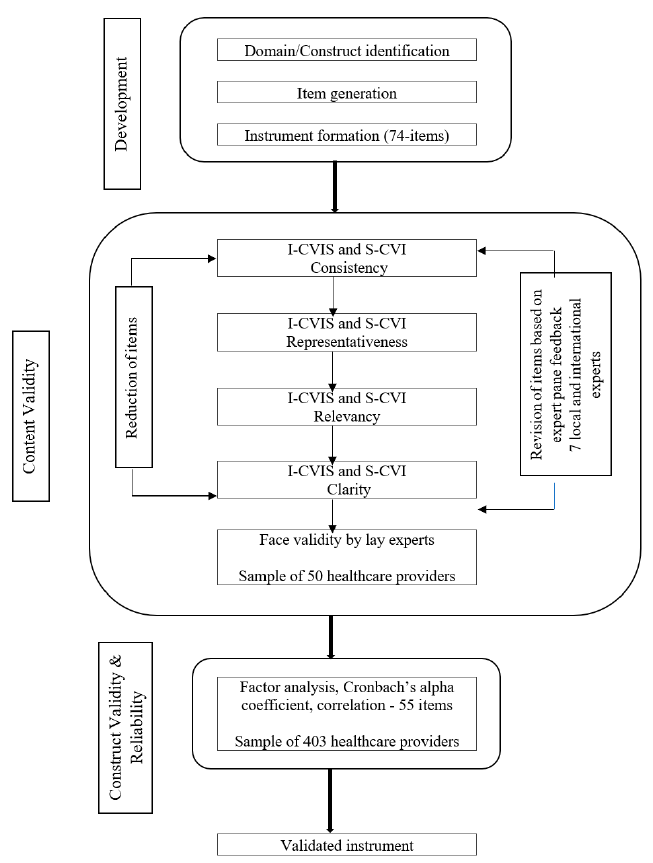
Figure 1. Steps of validity process.